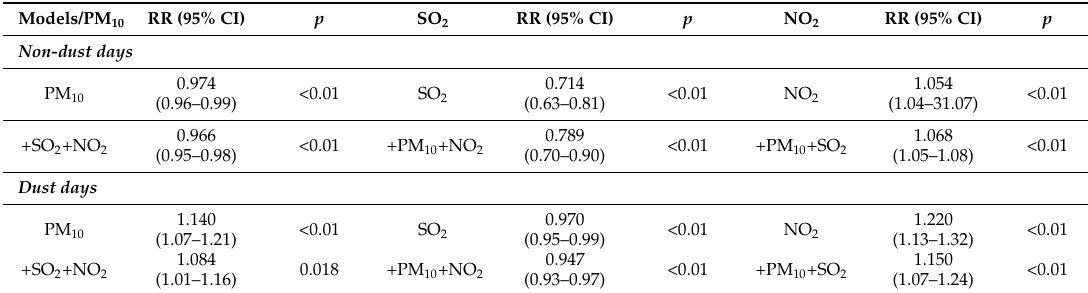
Table 2. RRs (95% CIs) per 10 µ g/m 3 increase in PM 10 , SO 2 and NO 2 on ER visits in single and multiple pollutant models in spring, 2007–2011